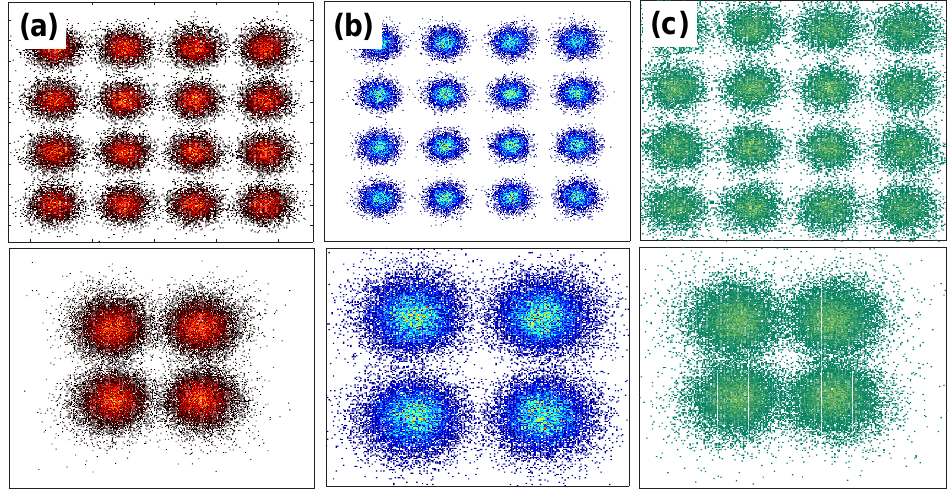
Figure 12. Experimental constellation diagrams for Data 1 and Data 2 for OFDM-NOMA ( a ) R, ( b ) G, ( c ) B channels.